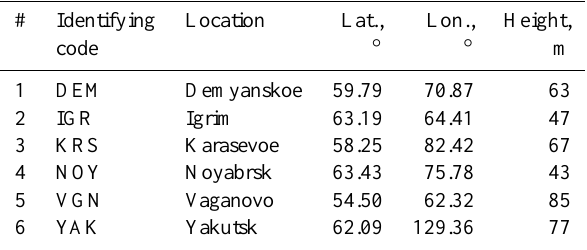
Table 3. Tower network sites in Siberia